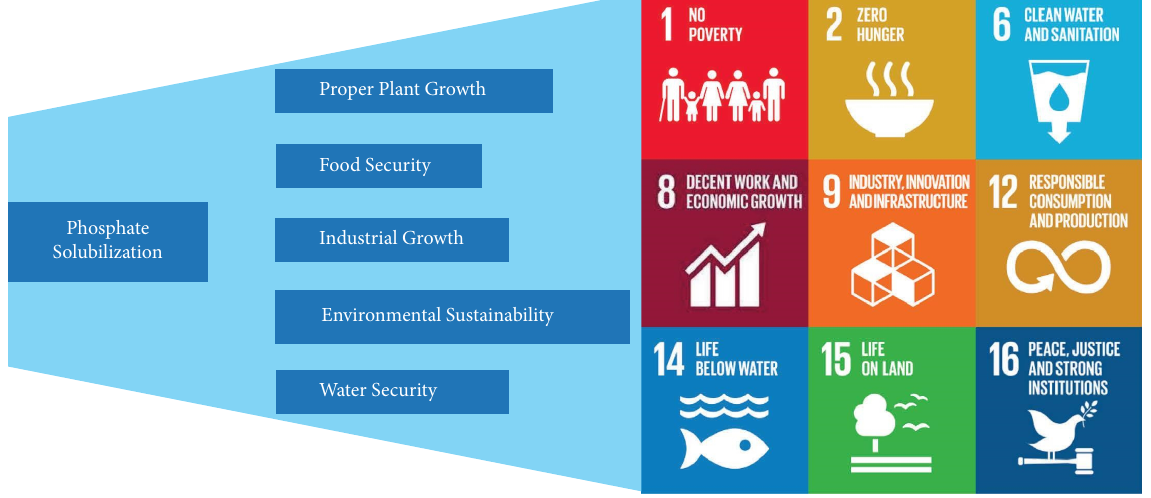
Figure 2: SDG related to Phosphate